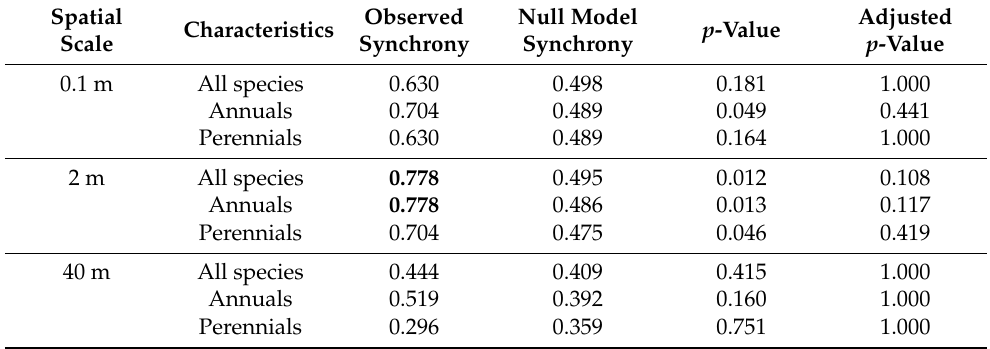
Table 2. Synchrony of species richness among sites. Corrected p -values were adjusted for multiple tests by the Bonferroni–Holm method. Bold numbers indicate marginally significant